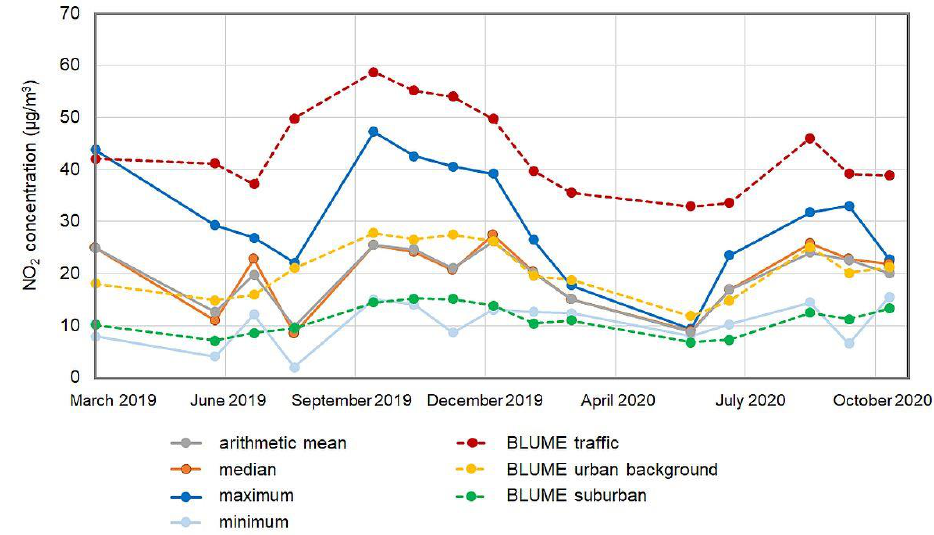
Figure 4. Seasonal trend of spatially and monthly averaged citizen science NO 2 concentrations (arithmetic mean, median, maximum, minimum), and monthly average NO 2 concentrations of three site categories (traffic, urban background and suburban) of BLUME monitoring network.